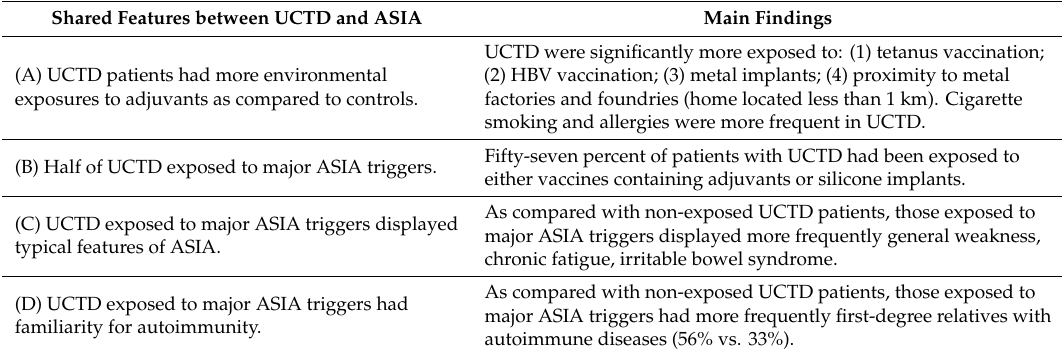
Table1. Featureslinkingundi ff erentiatedconnectivetissuediseaseandASIAsyndromeinacase–control study on environmental exposures [61]. ( UCDT : undi ff erentiated connective tissue disease). Shared Features between UCTD and ASIA Main